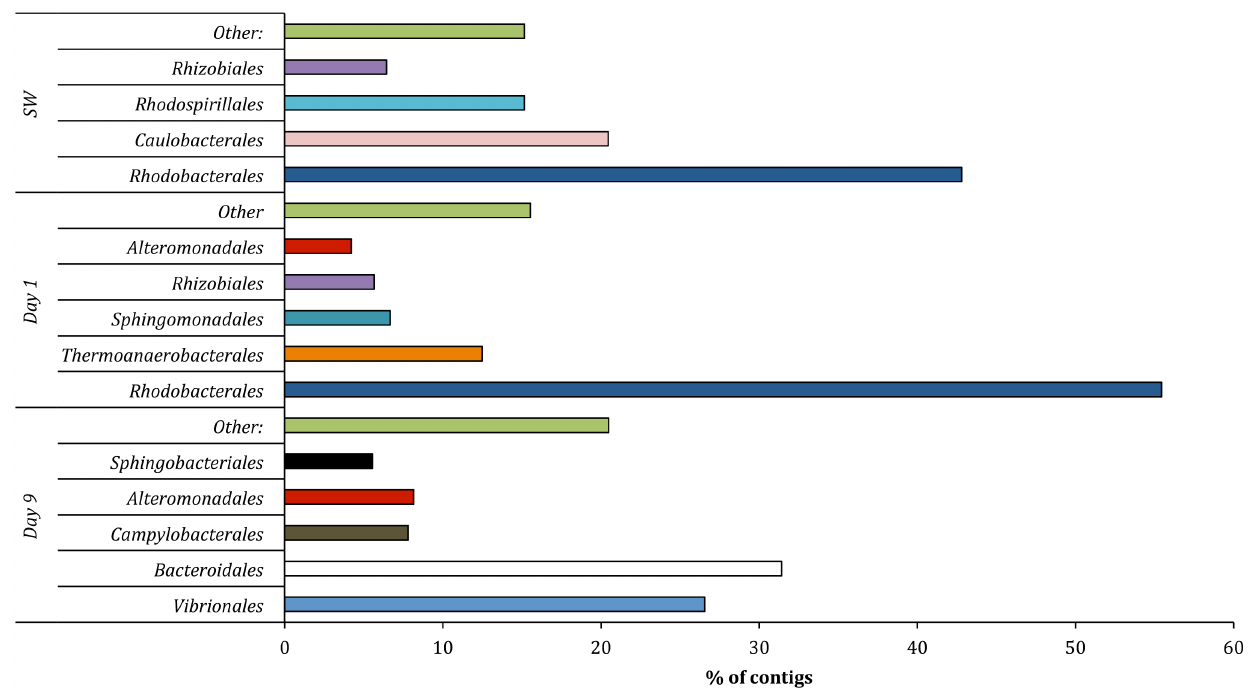
Figure 10. Taxonomic classification of sulfur metabolism contigs for each analyzed water sample as assigned by MGTAXA. SW- Source water; D1- Produced water day 1; D9- Produced water day 9. Only the top five bacterial orders to which most contigs were assigned to are shown in the figure. The less abundant bacterial orders are grouped as ‘‘other’’.